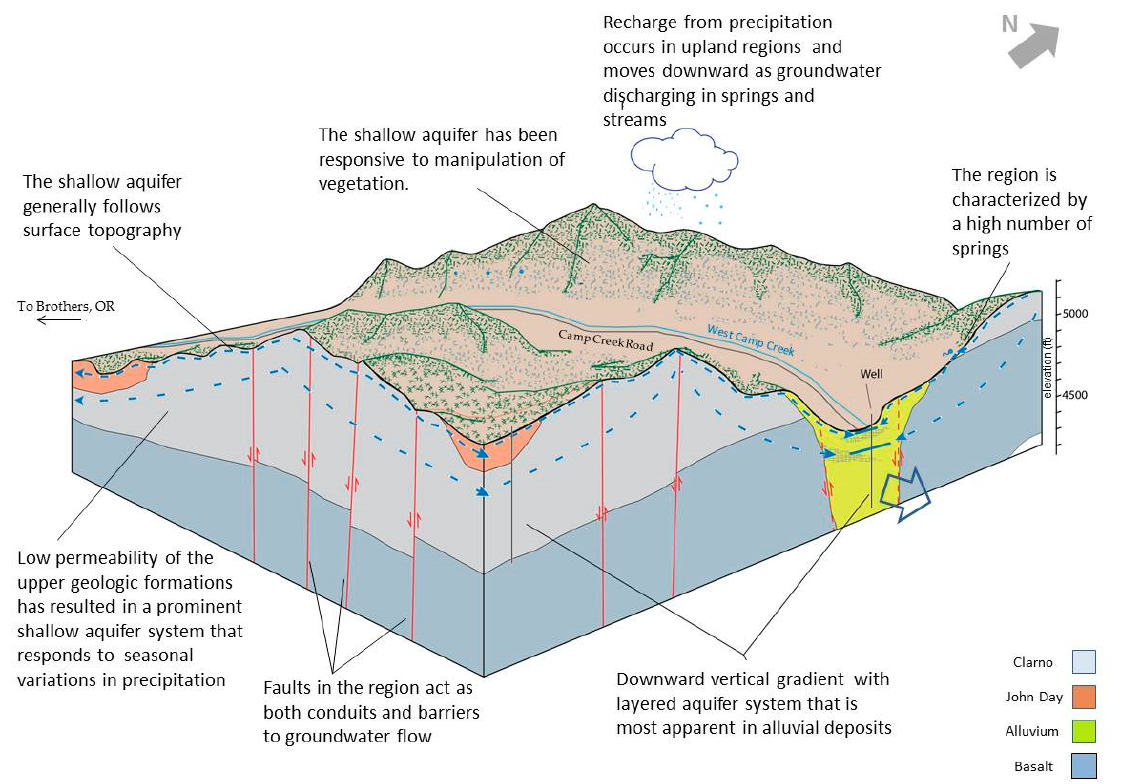
Figure 5. Conceptual model of local groundwater flow system based on a synthesis of topographic features and hydrogeologic information. The hydraulic connection between the sedimentary strata and the deeper basalt in the vicinity of the fault-bounded valleys is unknown but shown schematically.